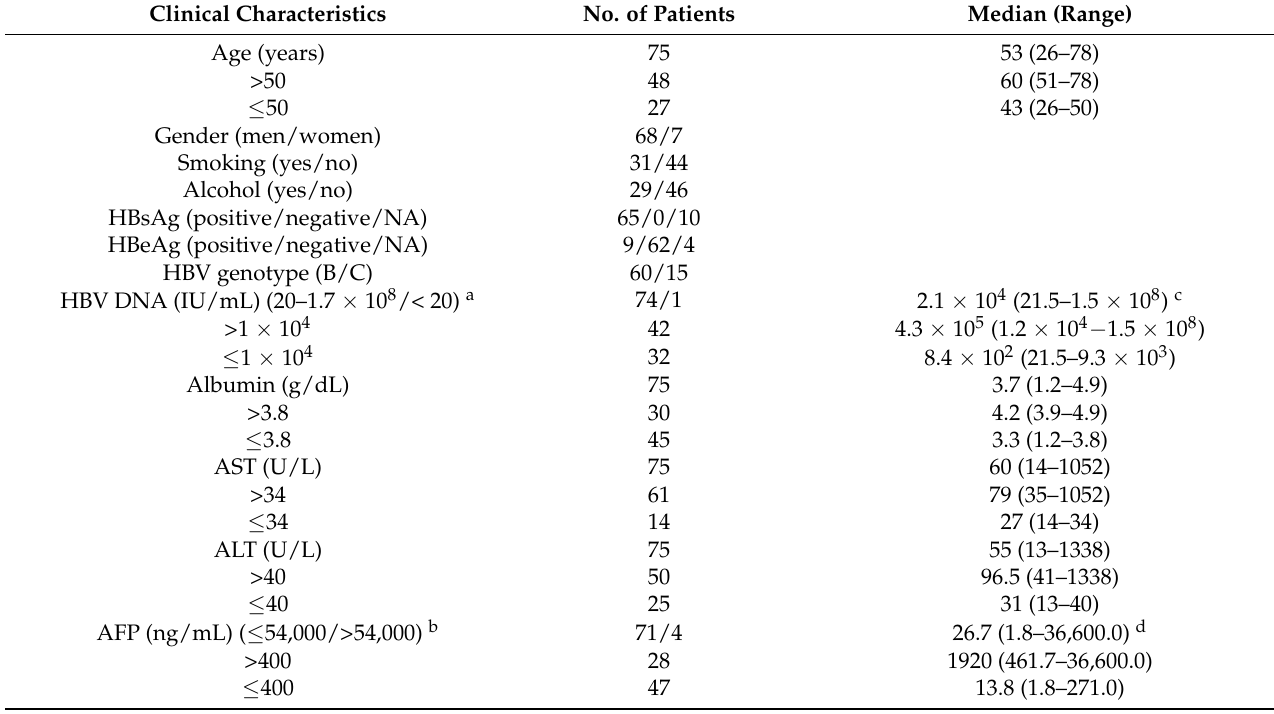
Table 1. Clinicopathological characteristics and pre-S genotyping of 75 HBV-related HCC patients enrolled in this study. Clinical